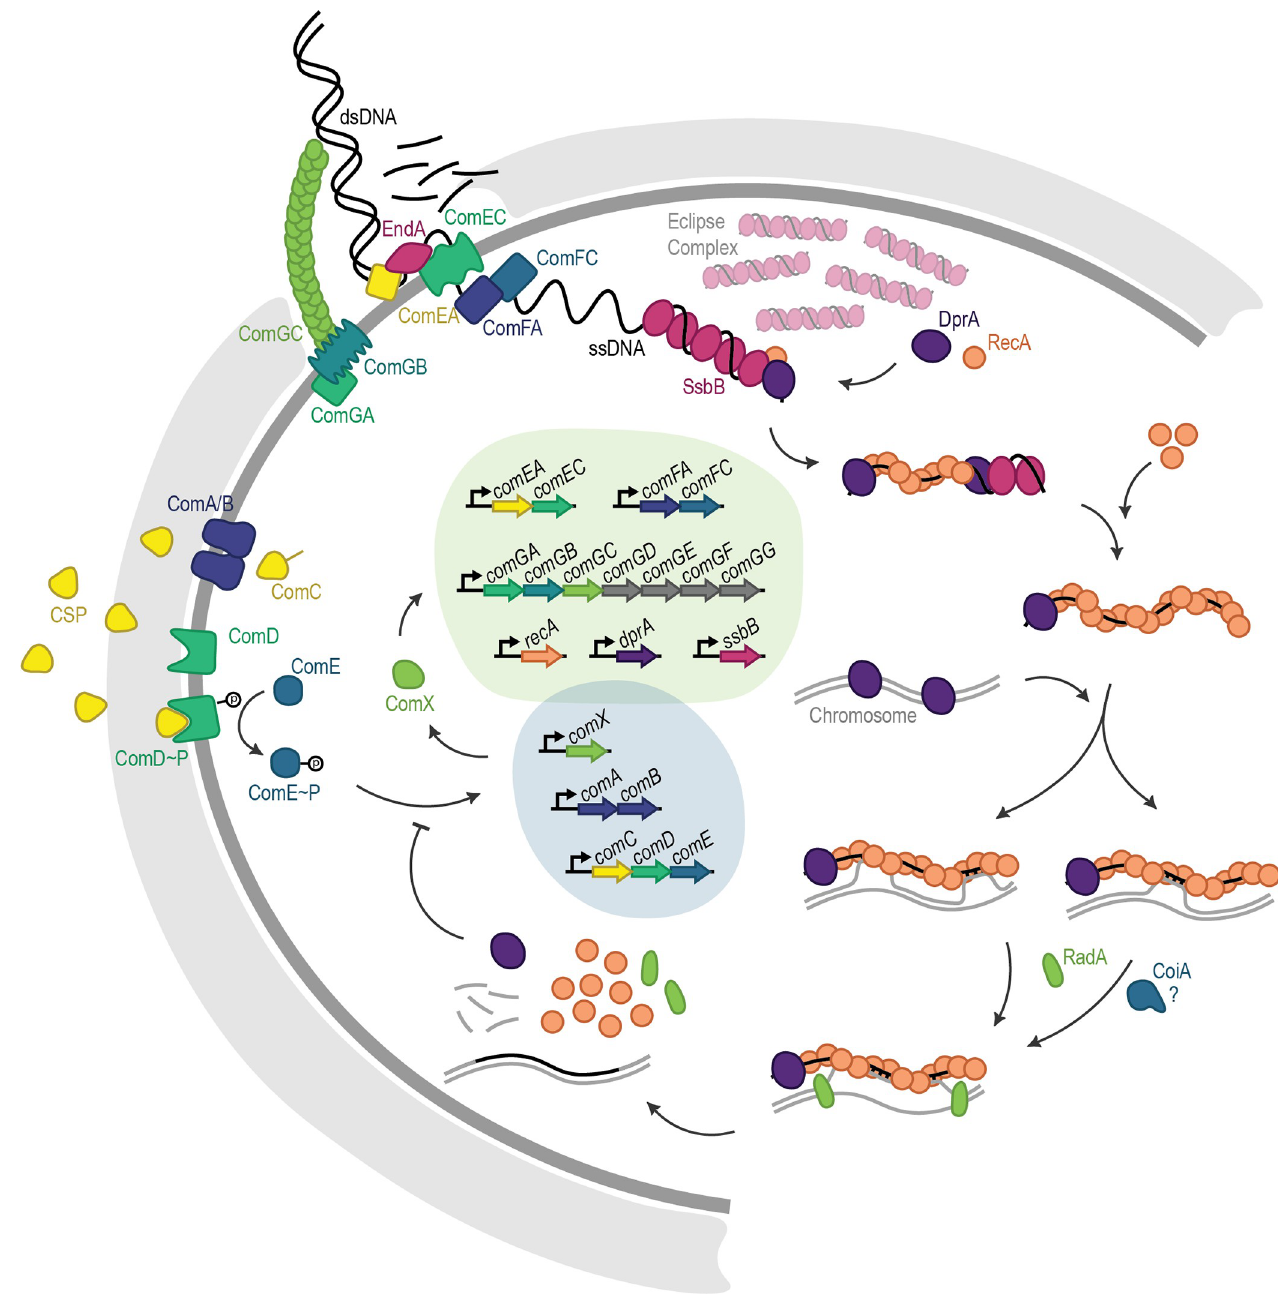
Fig 1. DNA uptake and recombination during natural competence in Streptococcus pneumoniae . Schematic overview of the regulatory steps required for the pneumococcus to uptake and recombine extracellular DNA. Competence is activated when CSP interacts with the ComDE two-component system, where phosphorylated ComE activates transcription of ComX and other early competence genes (darker grey bubble). This results in a positive feedback loop, where ComC is produced, then modified and exported from the cell by ComA/B as CSP. Meanwhile, ComX activates transcription of late competence genes, including the type IV-like pilus (ComGC), which brings DNA within reach of endonuclease EndA. EndA performs random nicks, then degrades one strand as the other is pulled into the cell and associated with DprA, RecA, and SsbB, to protect from degradation (exact mechanism not fully understood). DprA mediates loading of RecA onto SsbB-ssDNA eclipse complexes to form the presynaptic filament which then searches the chromosome for homology. RecA- ssDNA filaments may interact with the chromosome at multiple points, while successful base pairing between incoming and chromosomal DNA facilitates strand invasion and exchange. The helicase RadA facilitates D-loop extension, and CoiA is essential for successful recombination during transformation, although its exact role is not known. DprA is also involved in competence shut off, through blocking phosphorylation of ComE.